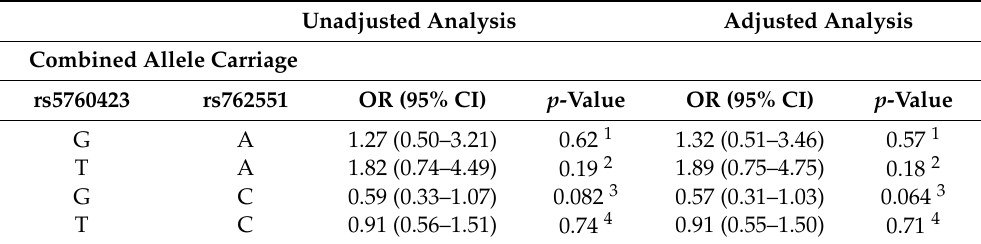
Table 6. Analysis for association between the combined allele carriage from ADORA2A rs5760423 and CYP1A2 rs762551 and AD. Unadjusted Analysis Adjusted